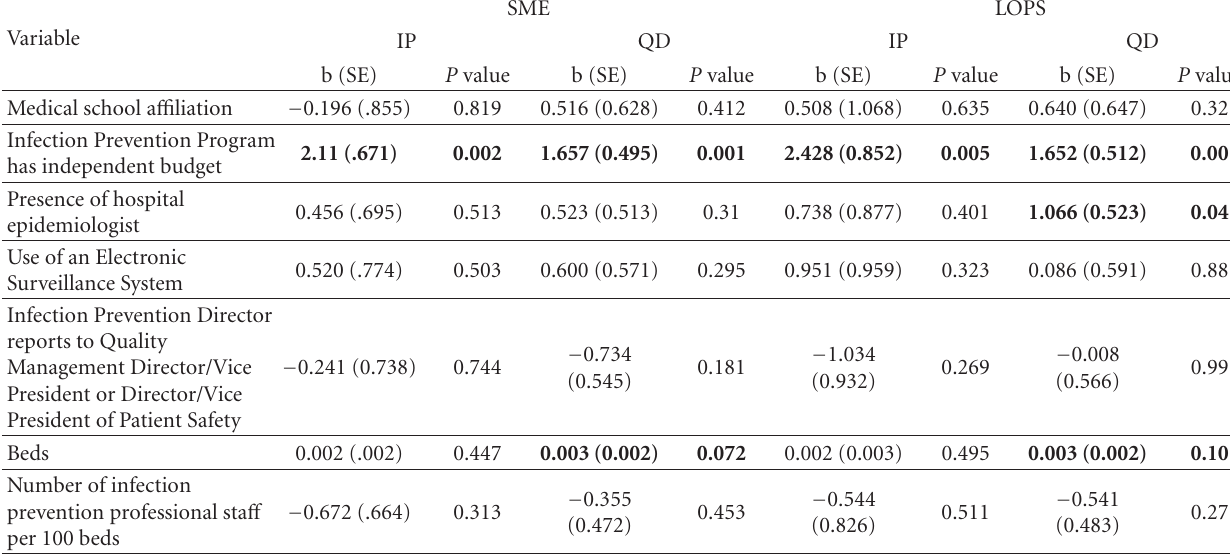
Table 3: Regression coe ffi cients from univariate analyses of hospital and infection prevention and control department characteristics and SME/LOPS scores.